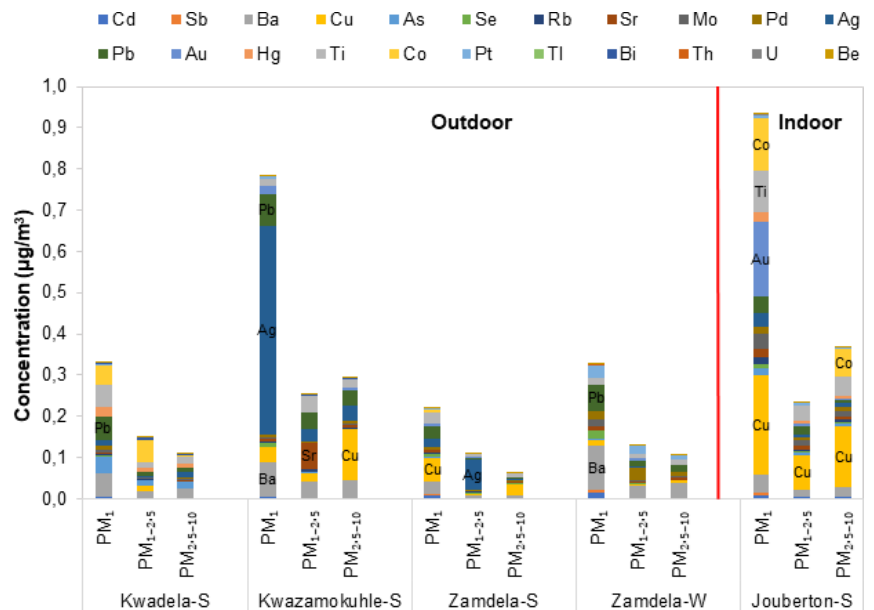
Figure A1. Mean concentrations of trace element species for which significantly lower levels were determined in PM 1 , PM 1 − 2 . 5 , and PM 2 . 5 − 10 at each site during respective sampling